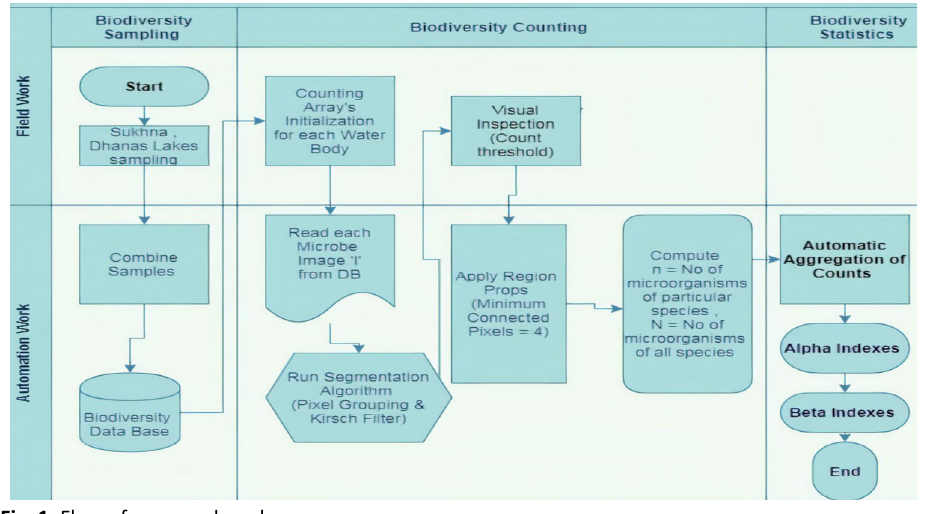
Fig. 1 . Flow of proposed